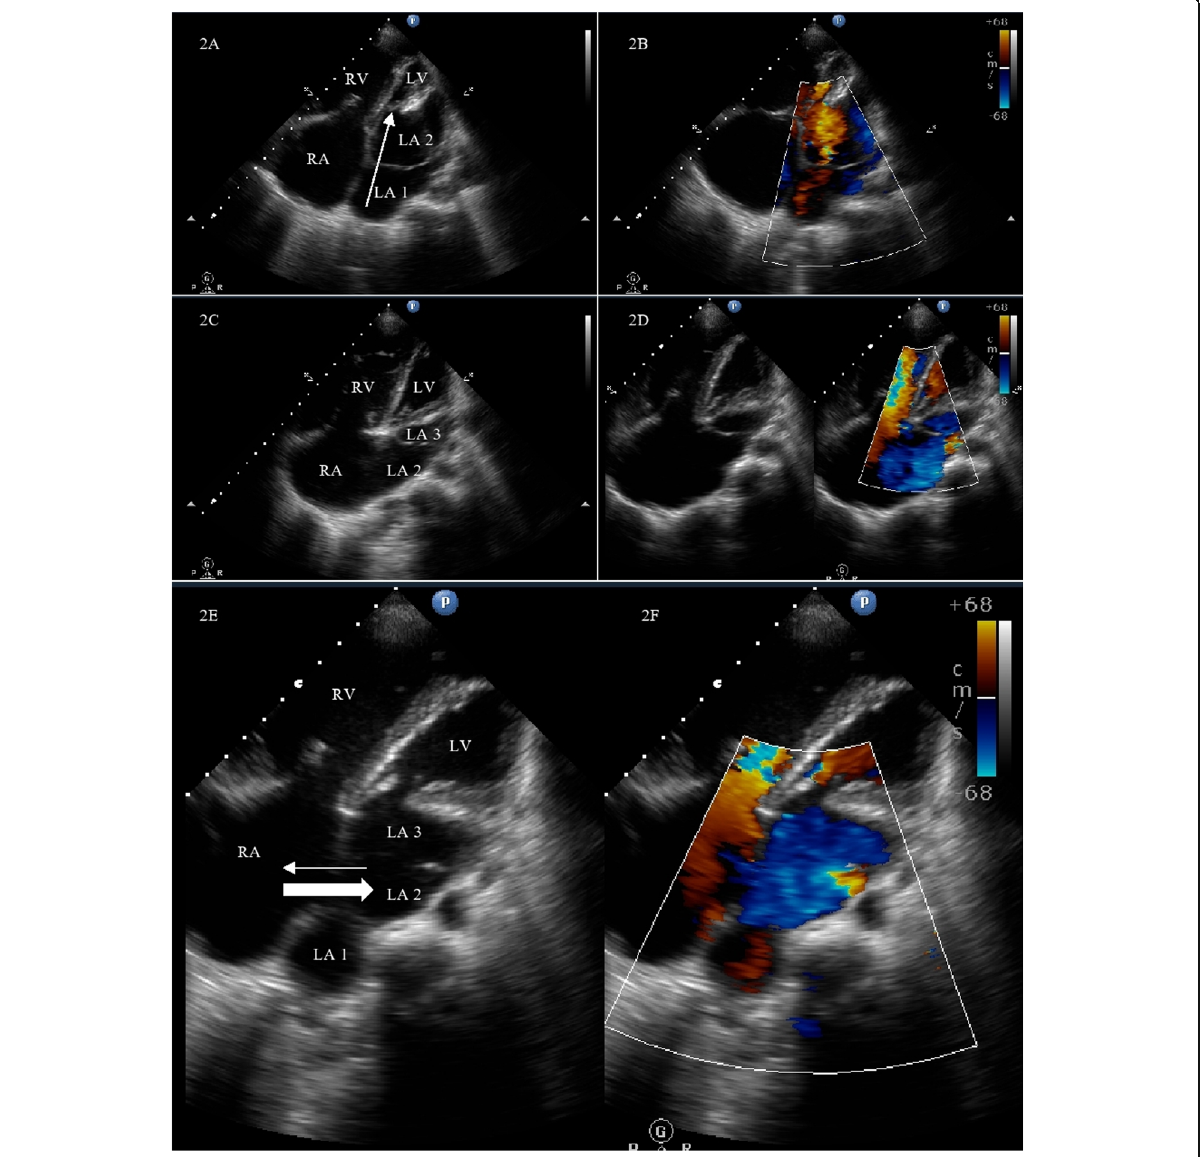
Fig. 2 Transthoracic echocardiography in apical 4 chamber (A4C) view showing left atrium (LA) divided into 2 chambers LA1 and LA2 by a membrane ( A ) with color Doppler showing pulmonary venous return progressing from proximal left atrium to left ventricle through the membrane (arrow) ( B ). Modified A4C view opening up the 3rd LA chamber (LA3) separated from LA2 by the supramitral ring with color Doppler showing flow through the supramitral ring ( C , D ). Modified A4C view showing all 3 LA chambers with LA2 communicating with right atrium through the atrial septal defect ( E , F ). The thicker arrow shows predominant right to left shunt, and the thinner arrow shows the small left to right shunt. RA, right atrium; LA, left atrium; RV, right ventricle; LV, left